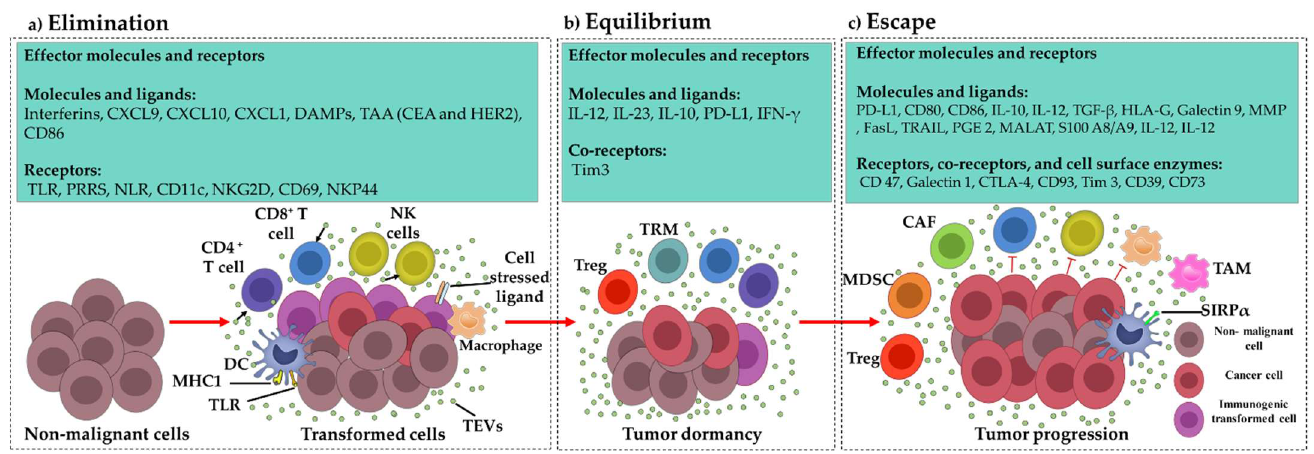
Figure 1. Cancer immunoediting and involved effector molecules and receptors: ( a ) During the elimination phase, the innate and adaptive immune systems work together to identify and eliminate transformed cells that have evaded genetic malignant cell suppression mechanisms. The generation of tumor antigens and extracellular vesicles by cancer cells trigger immunological responses against tumors that result in the detection and elimination of nascent cancer cells by the immune system ( b ) if they survive the elimination phase, tumors may reach the equilibrium phase. Adaptive and innate immunity limits tumor progression in this phase, therefore tumor growth is reduced, and surviving tumor cells are kept under control and possibly kept dormant by the immune system ( c ) Ultimately in the escape phase, tumors overcome the immune system by immune suppression through recruiting immunosuppressive cells, and suppressing effector immune cells via different mechanisms.